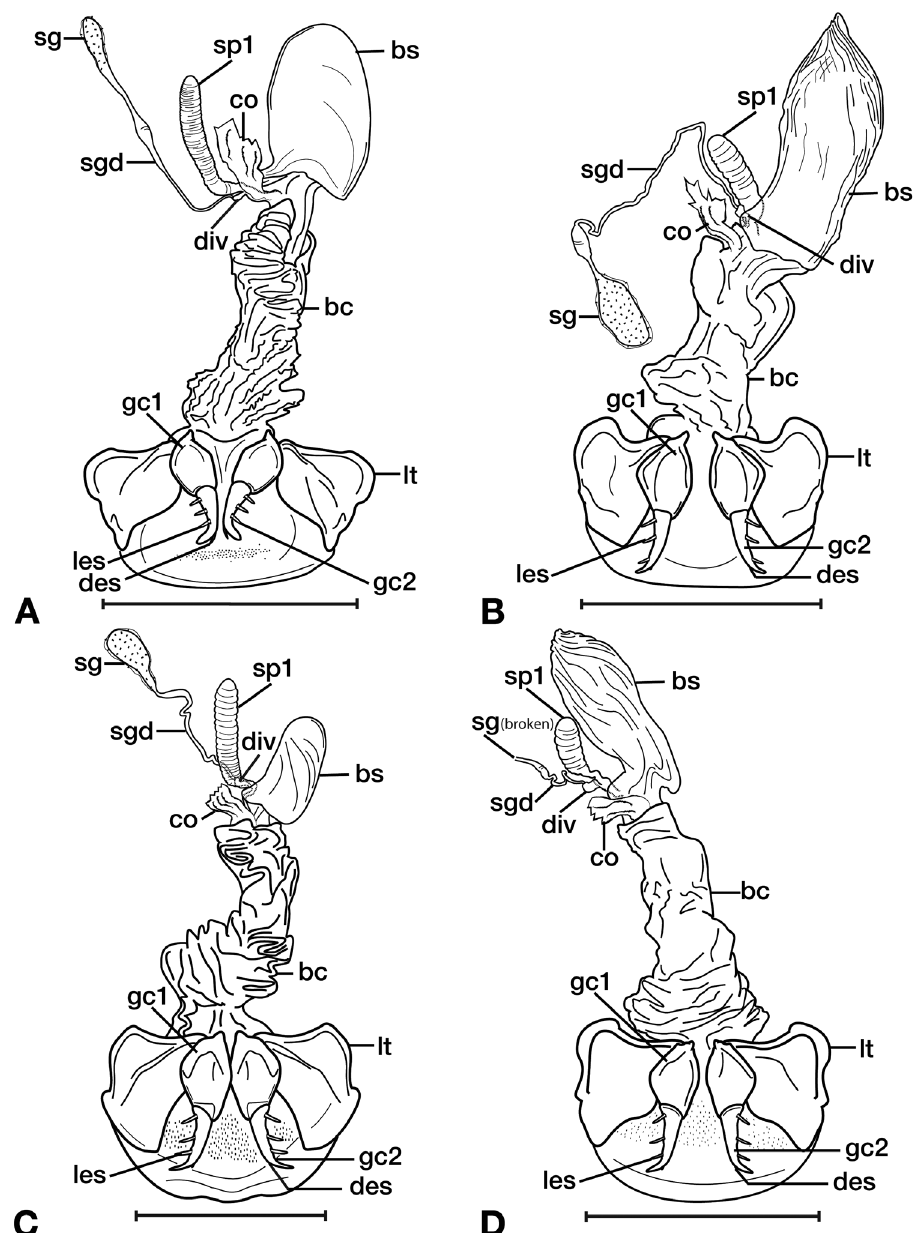
Figure 57. Line drawings of the female reproductive tract of species of the subgenus Coptoderina Jeannel, known from Taiwan (in part), ventral aspect. A C. ( C. ) chaudoiri Andrewes B C. ( C. ) eluta Andrewes C C. ( C. ) japonica Bates D C. ( C. ) maculata (Dupuis). Legend: bc bursa copulatrix; bs blind sac; co com- mon oviduct; des dorsal ensiform setae; div diverticulum; gc1 gonocoxite 1; gc2 gonocoxite 2; les lateral ensiform setae; lt lateral tergite; sg spermathecal gland; sgd spermathecal gland duct; sp1 spermatheca 1. Scale bars: 1